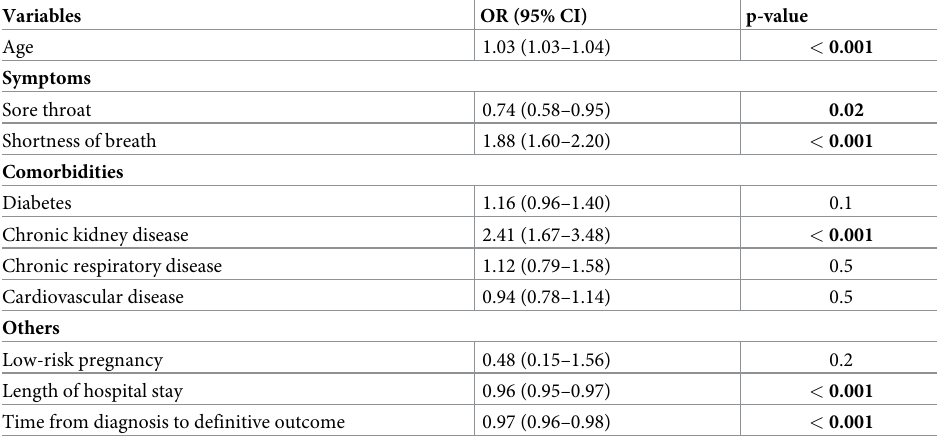
Table 2. Risk factors associated with the mortality of hospitalized COVID-19 patients.